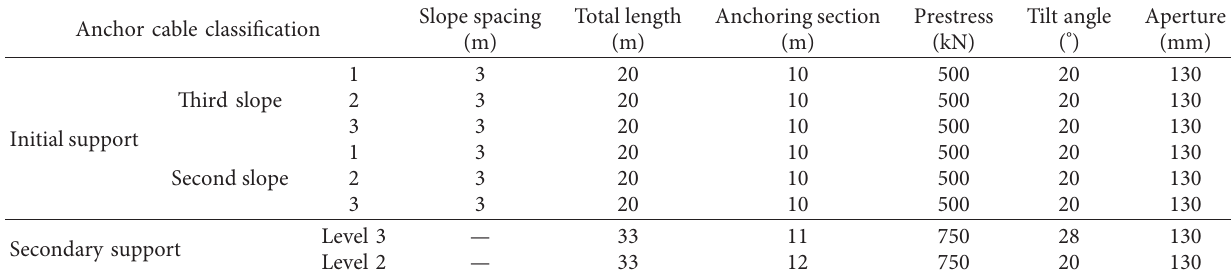
Table 4: Parameters of the anchor